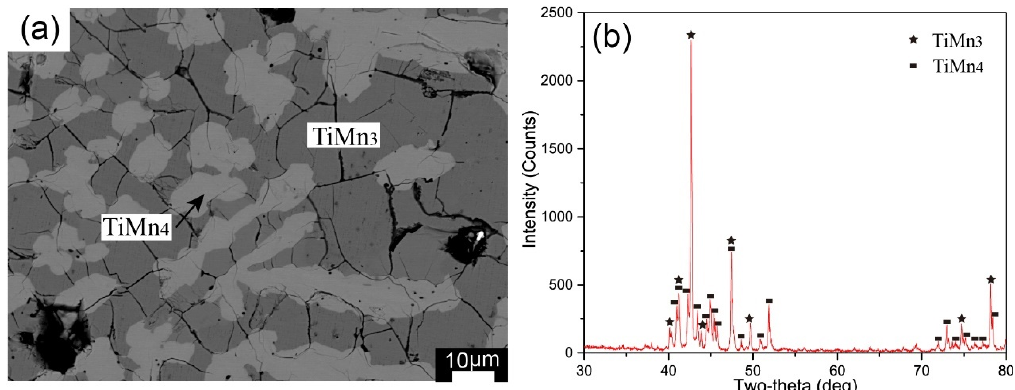
Figure 22. Alloy B25 annealed at 1273K for 60 days: ( a ) BSE images, ( b ) XRD patterns. It can be observed in Figure 23 that the alloy B21, B22 and B24 are respectively in 3 two-phase equilibrium fields: TiMn 4 + α Mn, (Ti,Nb)Mn 2 + α Mn and (Ti,Nb)Mn 2 + β Mn; the alloy B14 is in the solid solution field: (Ti,Nb)Mn 2 .